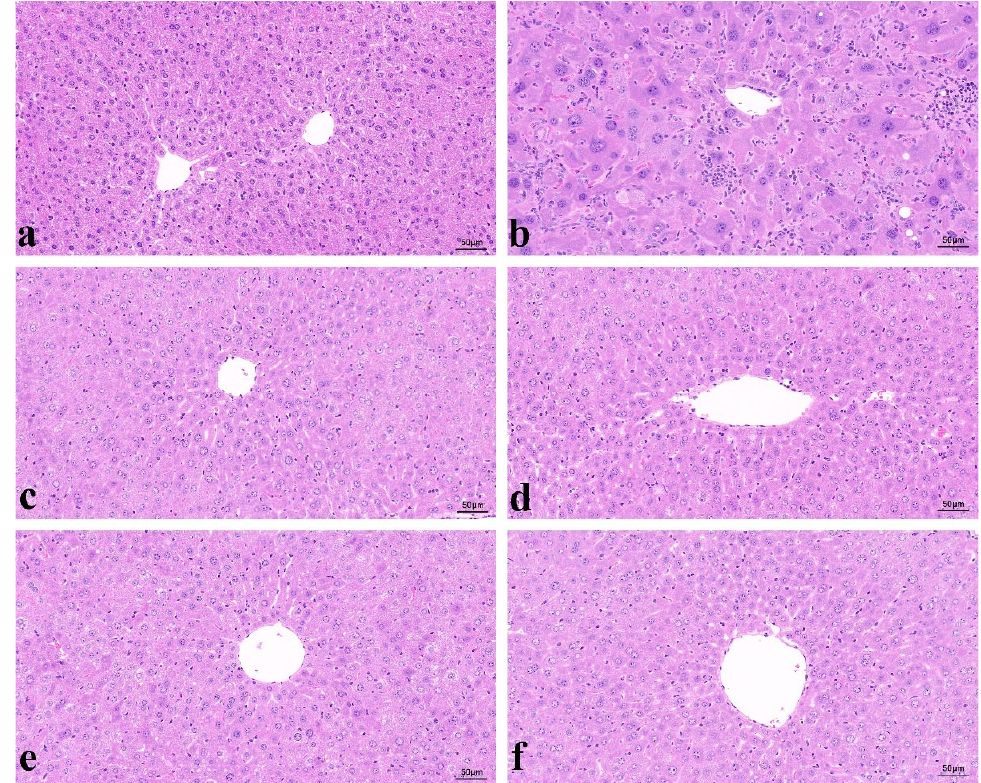
Figure 3. Histopathological effects of FDO, DDO, FDOP, and DDOP on CCl 4 ‐ induced hepatic injury (×200). Liver tissues were obtained from normal control mice ( a ), CCl 4 ‐ treated mice ( b ), FDO + CCl 4 ‐ treated mice ( c ), DDO + CCl 4 ‐ treated mice ( d ), FDOP + CCl 4 ‐ treated mice ( e ), DDOP + CCl 4 ‐ treated mice ( f ). NC: negative control; CCl 4 , tetrachloromethane, widely used to induce toxic liver injury in various experimental animals.